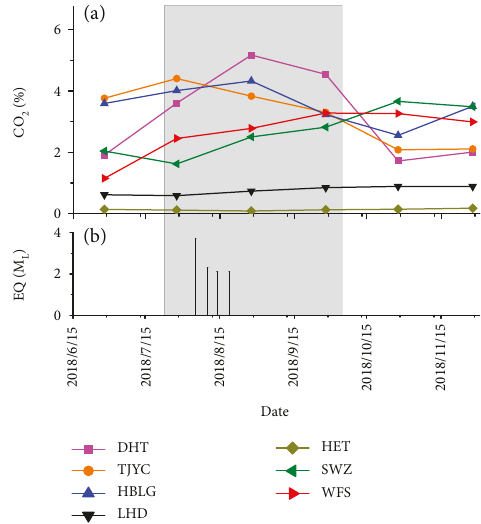
Figure 13: Relationship between earthquakes and soil gas chemical